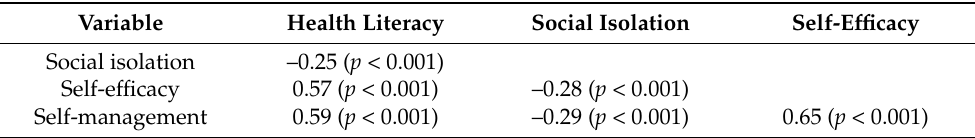
Table 2. Correlations between health literacy, social isolation, self-efficacy, and self-management ( N = 524).